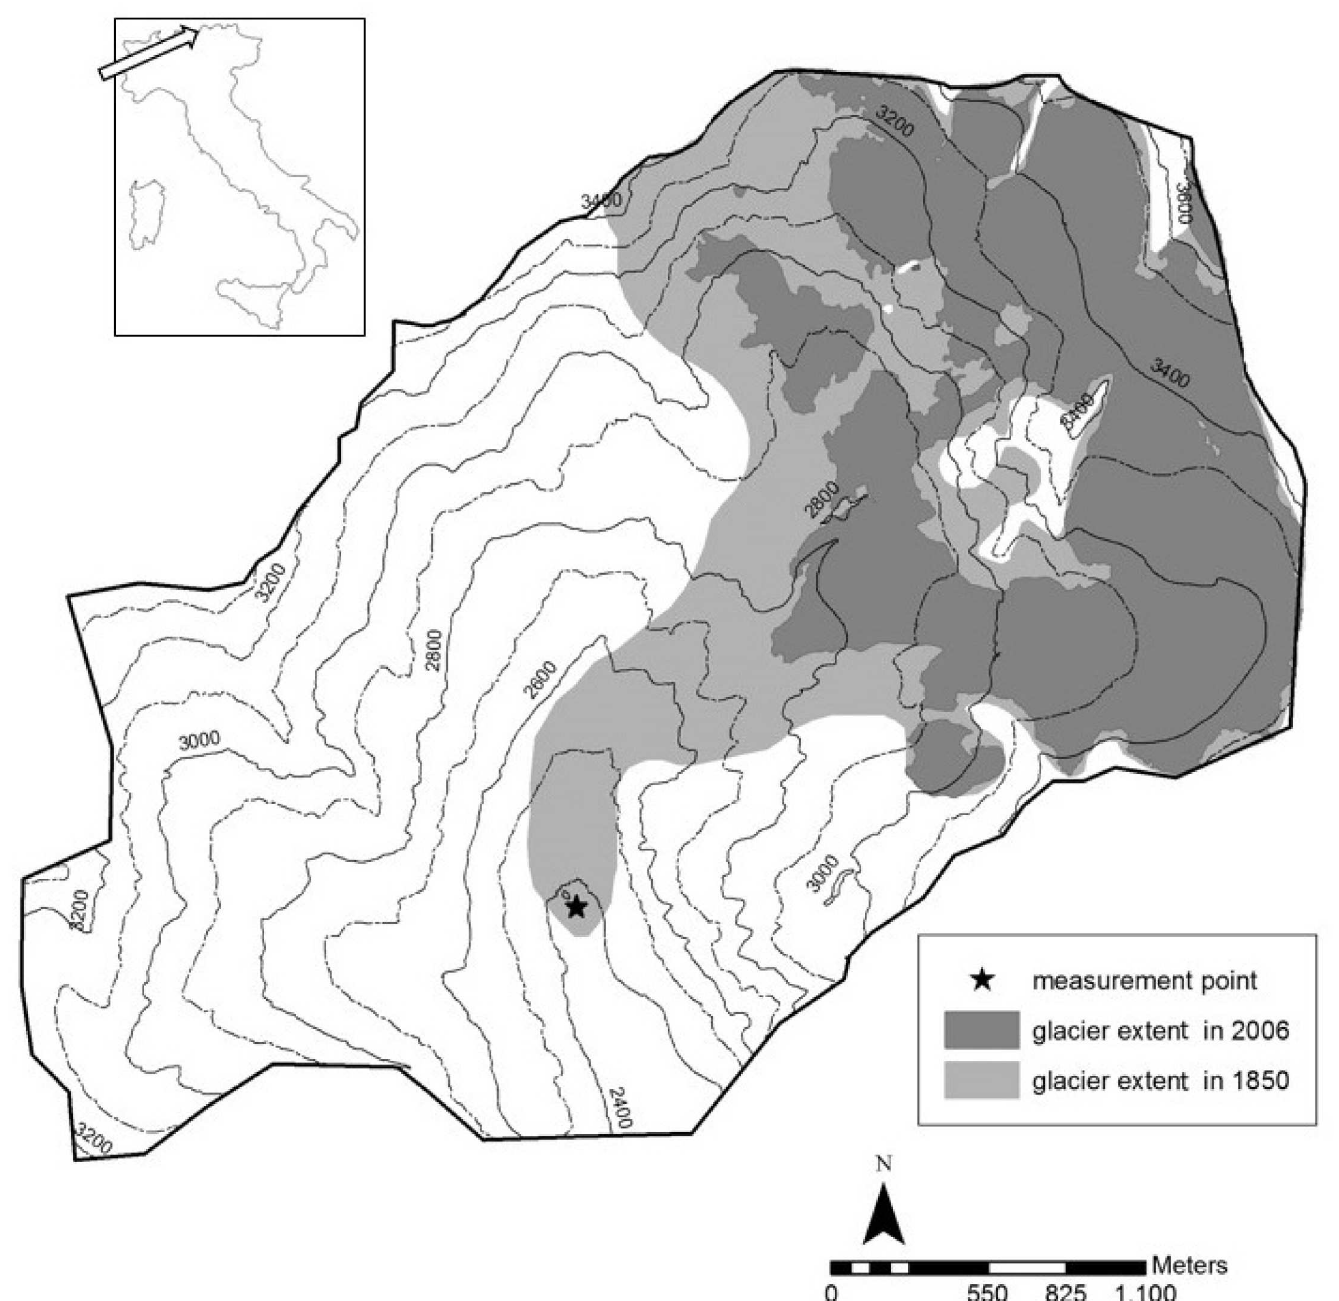
Fig 1. Study area in the upper Matsch valley (Northern Italy). The glacier extent in 2006and 1850 is shown. The star indicatesthe site of